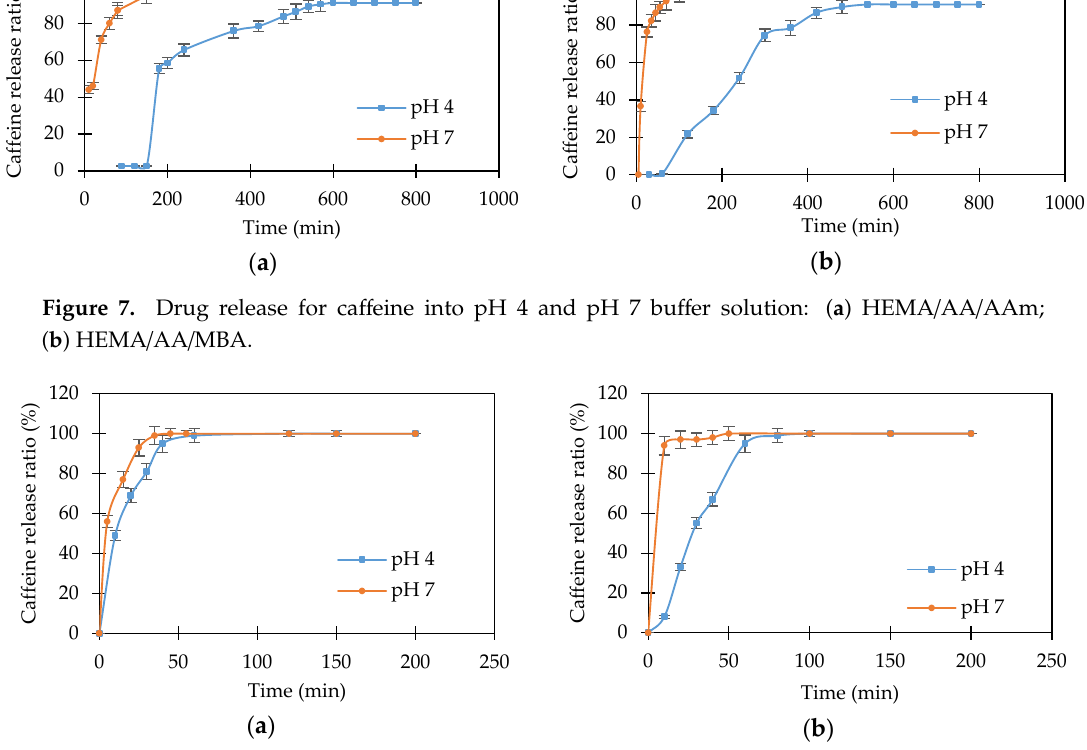
Figure 8. Drug release for caffeine into pH 4 and pH 7 buffer solution: ( a ) BMA/AA/AAm; ( b ) BMA/AA/MBA.